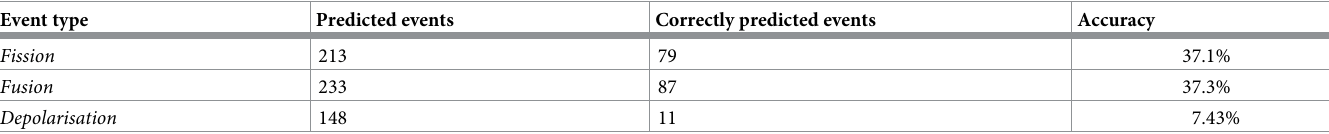
Table 7. The location prediction accuracies of the three-dimensional Vox2Vox GAN for mitochondrial fission, fusion and depolarisation events. Event